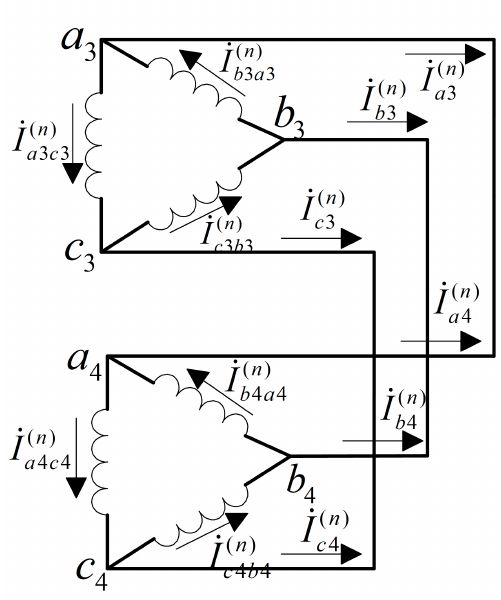
Figure 2. Transfer path of the 12 k − 5,12 k − 7 ( k = 1,2,3, . . . ) -th harmonic current. Next, the mechanism of 12 k − 5, 12 k − 7 ( k = 1, 2, 3, . . . ) -th harmonic suppression